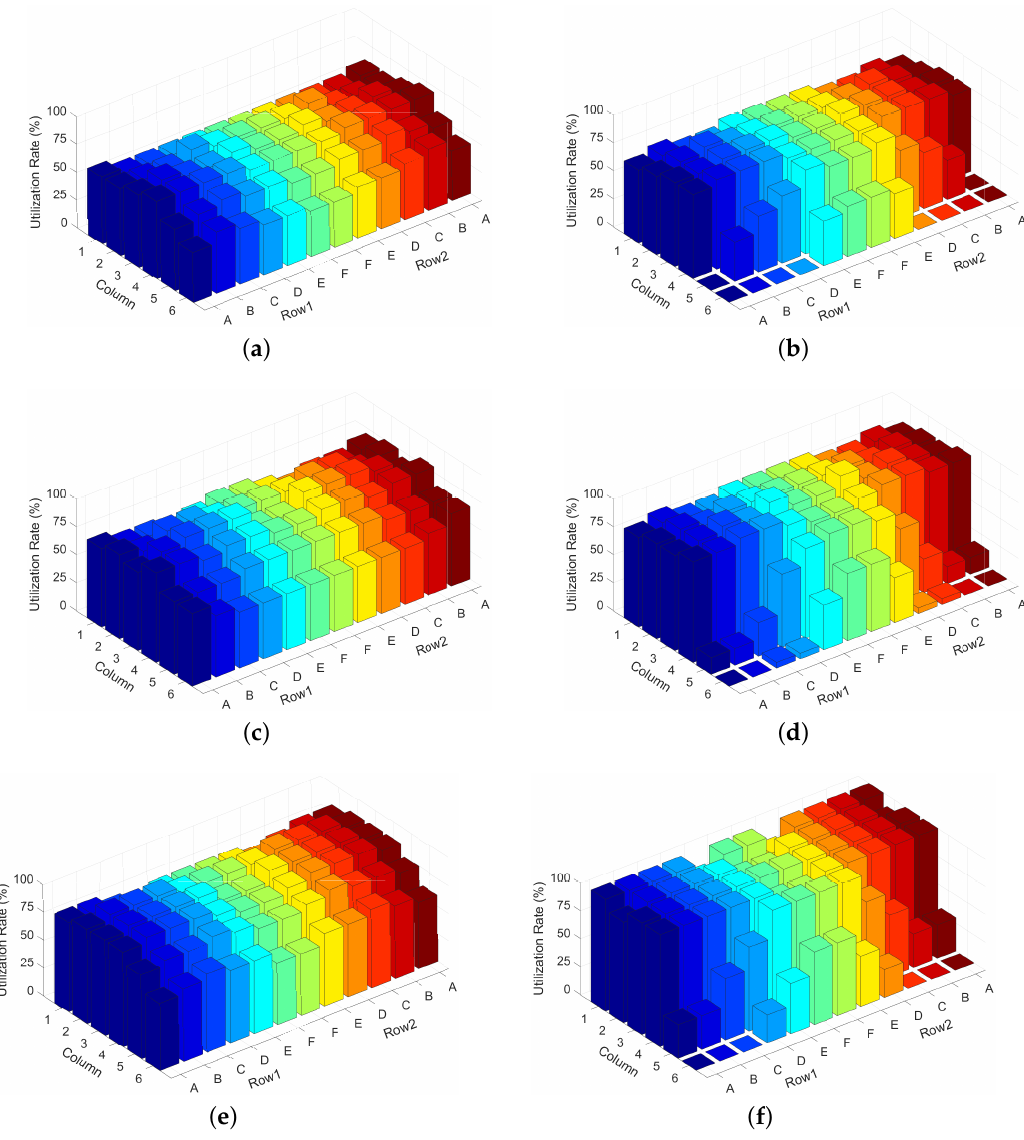
Figure 9. Workload allocation results for different data center utilizations. ( a ) Allocation result of chip temperature-based workload allocation strategy (CTWA-MTP) with 60%